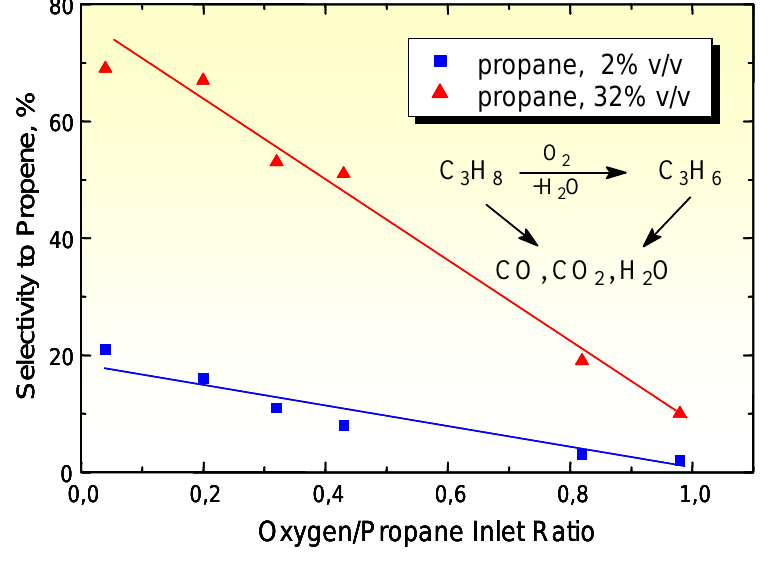
P O as a function of the inlet 2 2 7